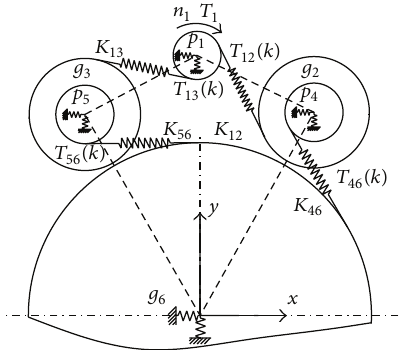
Figure 2: Schematic of mechanical structure